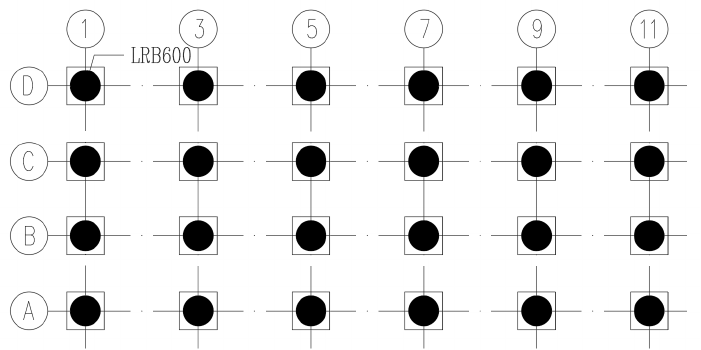
Figure 17. Layout of isolation layer.